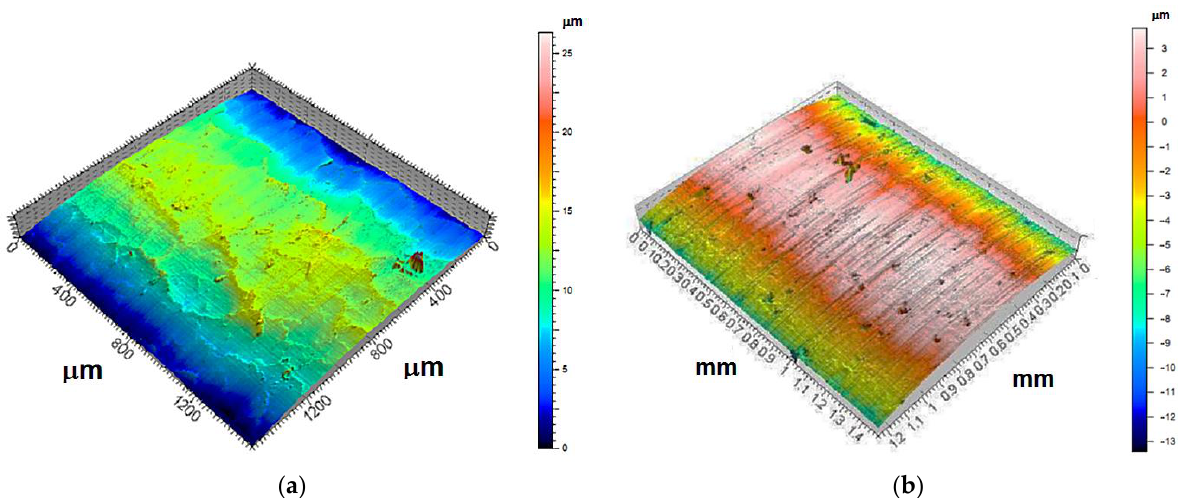
Figure 9. The example of the surface topography of the composite coatings with volume fraction ceramic dispersed phase ( a ) V cdp = 0%Al 2 O 3 , ( b ) V cdp = 15%Al 2 O 3 , after burnishing.